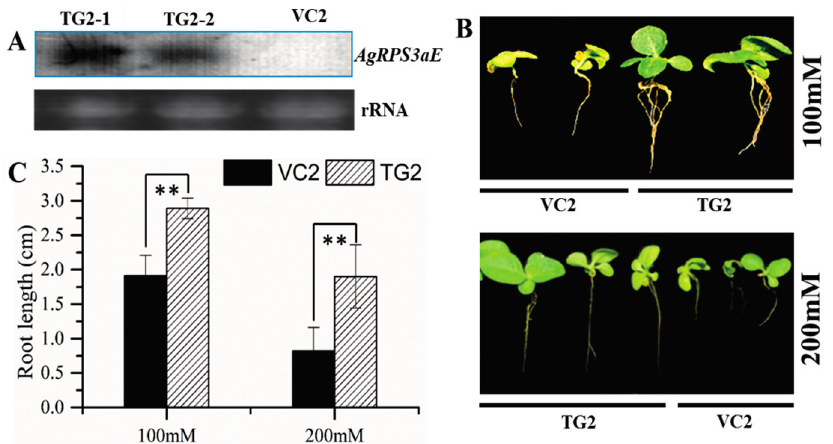
Figure 7. Effect of salt stress on tobacco seedlings from VC2 and T2 progenies of transgenic lines overexpressing AgRPS3aE . ( A ) Northern blotting analysis of three independent T2-generation transgenic tobacco lines; ( B ) The phenotypes of VC2 and T2 progenies tobacco seedlings stressed with 100 mM or 200 mM NaCl for 15 days; ( C ) The root lengths of VC2 and T2 progenies tobacco seedlings stressed with 100 or 200 mM NaCl for 15 days. The data are presented as the means ± SD of three